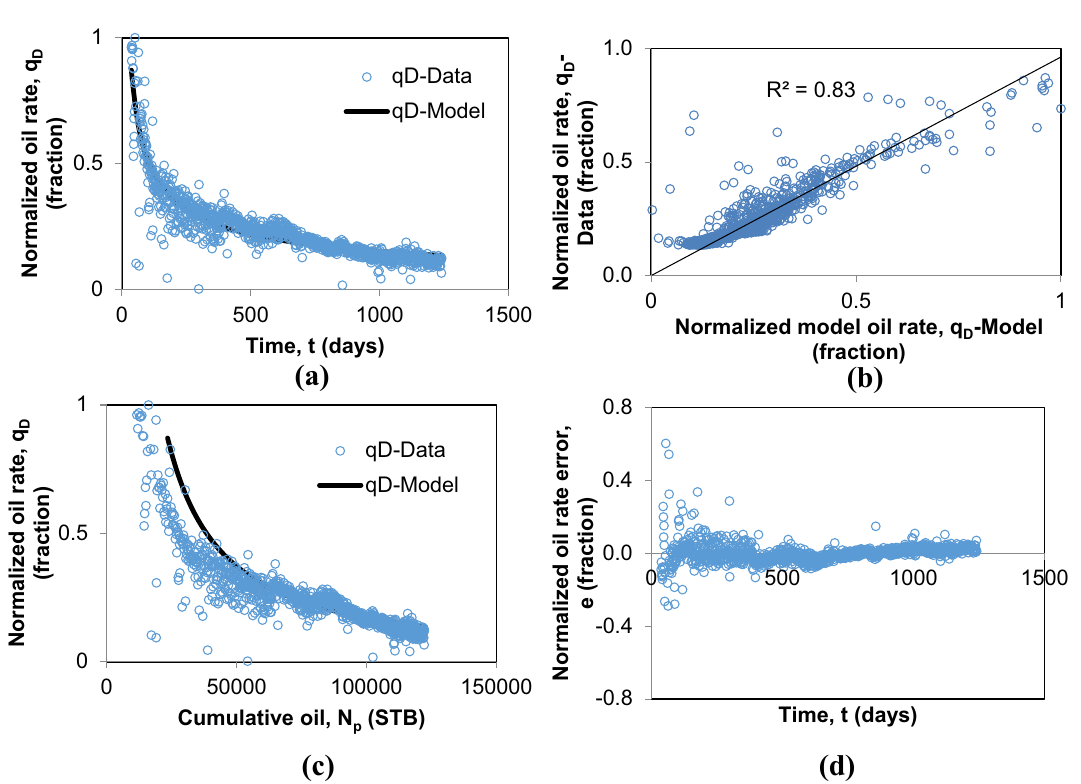
normalized rate data and the normalized model rate prediction. d Plot of the error in rate prediction ( q Data - q Model ) versus